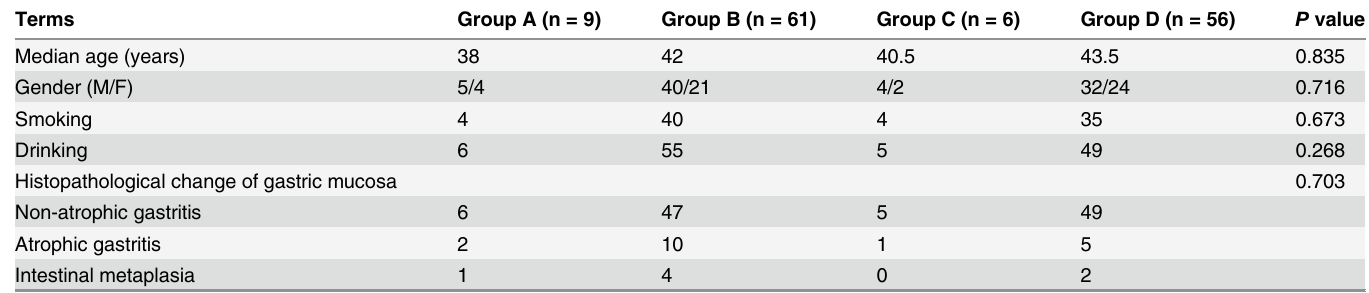
lower in patients with H . pylori infection when compared with those with no H . pylori infection ( P < 0.05; Figs 2 and 3). In contrast, both the protein and mRNA levels of IL-8 were significantly elevated in patients with H . pylori infection and no family histories of gastric cancer than those without both H . Table 2. Clinical characteristics of patients in this study.